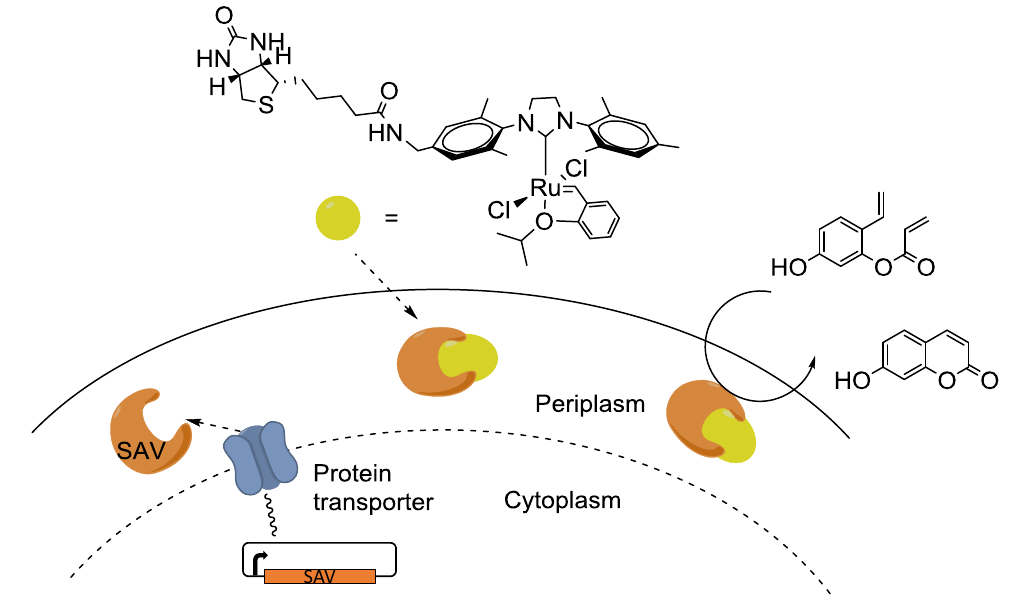
Figure 1. Streptavidin (SAV)-based artificial metalloenzymes for in vivo metathesis. The dashed arrows indicate the transportation of the chemical catalyst and streptavidin into the periplasm. Reprinted with permission from Macmillan Publishers Ltd: Nature [86]. Copyright 2016.